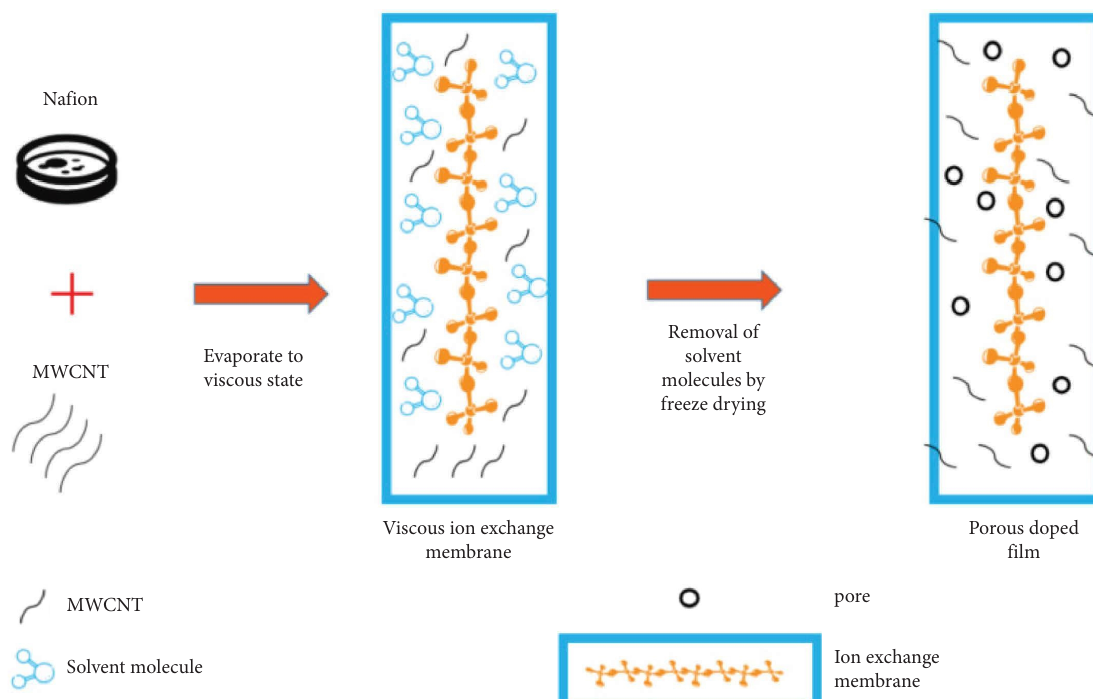
Figure 2: Freeze